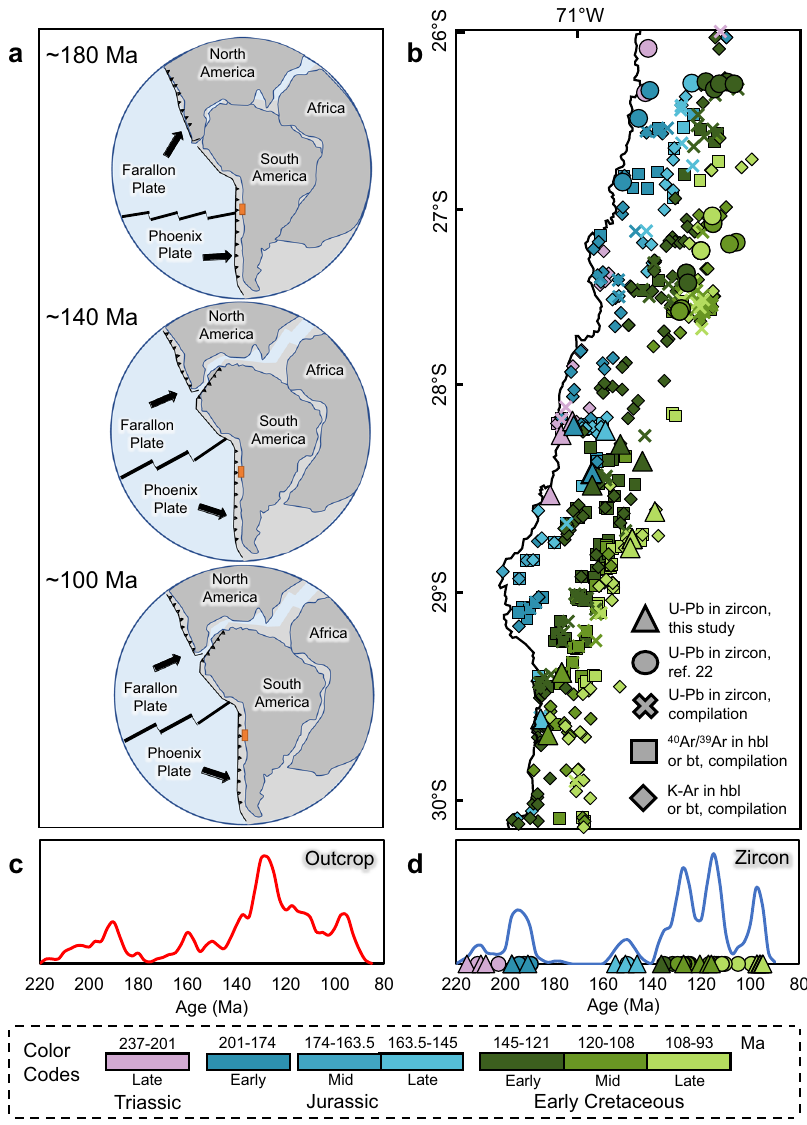
Fig. 1 Geotectonic setting of the early Andes in northern Chile and outcrop/zircon ages in the study area. a Geotectonic setting of Gondwana ’ s southwestern margin during the early Andean tectonic cycle (~200 – 100 Ma). b Outcrop ages of plutonic complexes in the study area; symbol colours refer to age of plutonic complexes. c Probability distribution function of outcrop ages in the study area. b , c Include compiled data reported in the Supplementary Data 1, Supplementary Data 2 and Supplementary Data 3. d Probability distribution function of zircon 238 U/ 206 Pb ages in the study area, including data from Supplementary Data 1 and Supplementary Data 2. c , d Probability distribution functions were calculated using a kernel density estimation process with a bandwidth of 2.5 Ma and a bin width of 5